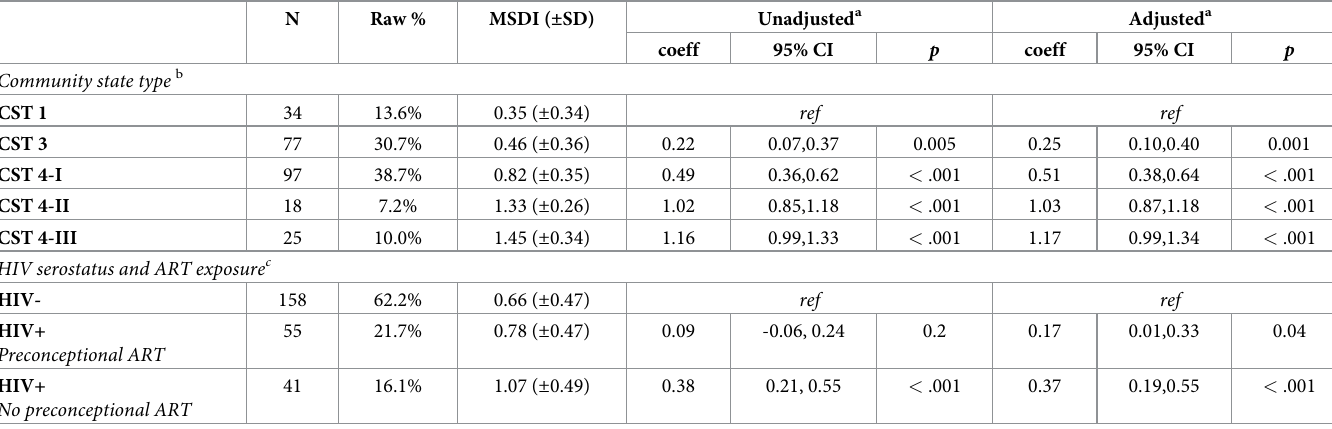
Table 2. Mean Shannon diversity indices (MSDI) in 5 major community state types and by HIV serostatus and timing of antiretroviral therapy